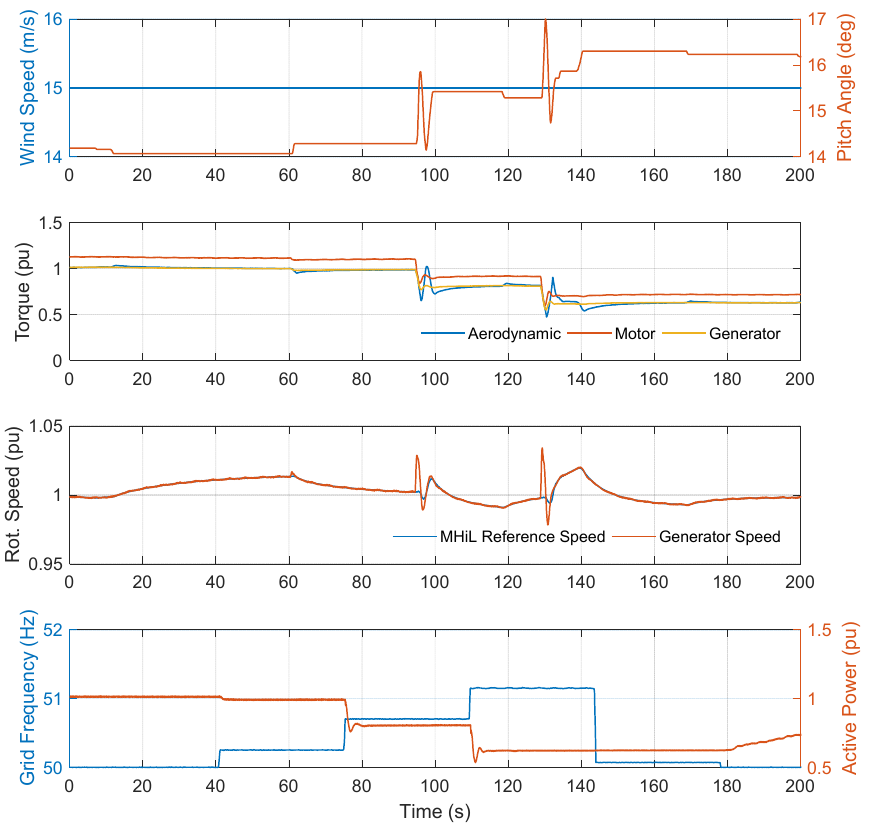
Figure 14. P(f) test according to TR3 Rev. 24.